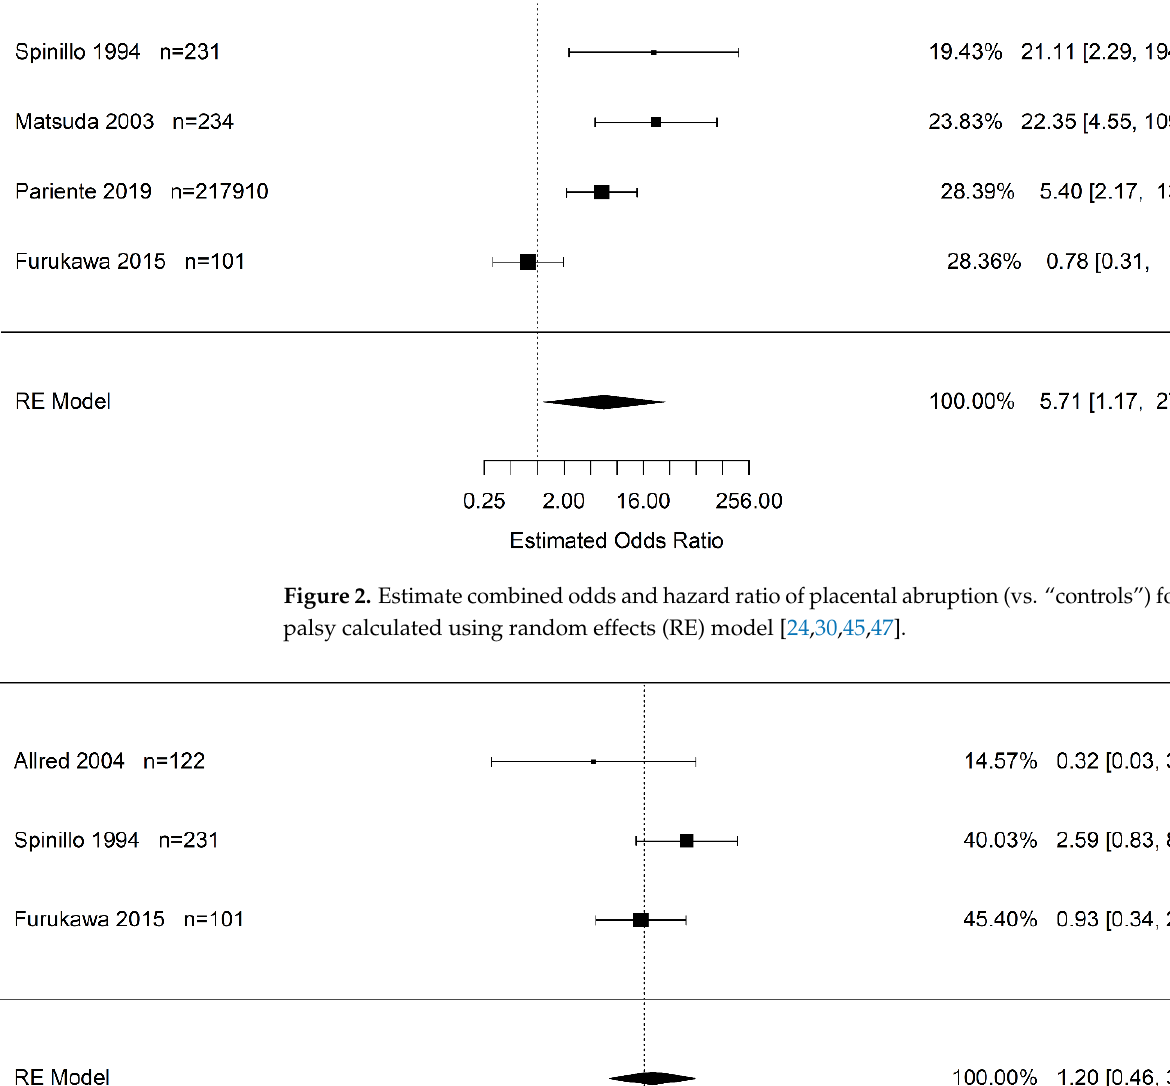
Good 3.4. Synthesis of Results Of the eight studies that included one of our outcomes of interest (i.e., cerebral pal ‐ sy, IVH or PVL), only five were suitable for meta ‐ analysis [24,30,45,50,58]. At least two of the five studies directly compared the risk of one of our outcomes of interest. Spinillo et al., 1993 [44], could not be added to avoid the possibility of patient overlap, and only one study measured brain damage at autopsy [51]. Four studies specifically reported on the association of abruption with cerebral palsy [24,30,45,58]. Since we had fewer than 10 studies in this meta ‐ analysis, we did not perform a meta ‐ regression based on the Cochrane handbook [59] to examine the effect of gestational age and placental abruption on cerebral palsy. Therefore, we could not examine the impact of decreasing gestational age on birth asphyxia and consequently the risk of cerebral palsy [60,61]. Results of the random effects meta ‐ analysis show that the odds of infants born to